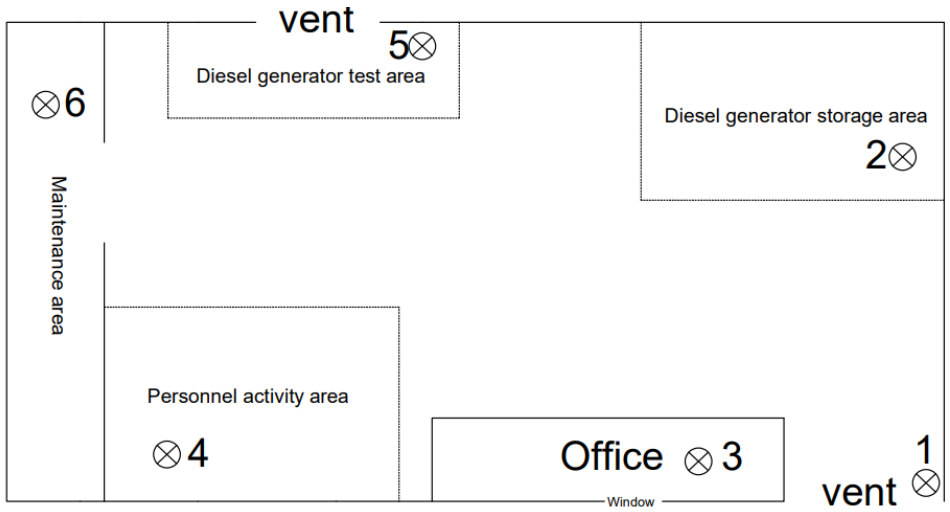
Figure 3. Schematic diagram of diesel generator plant.